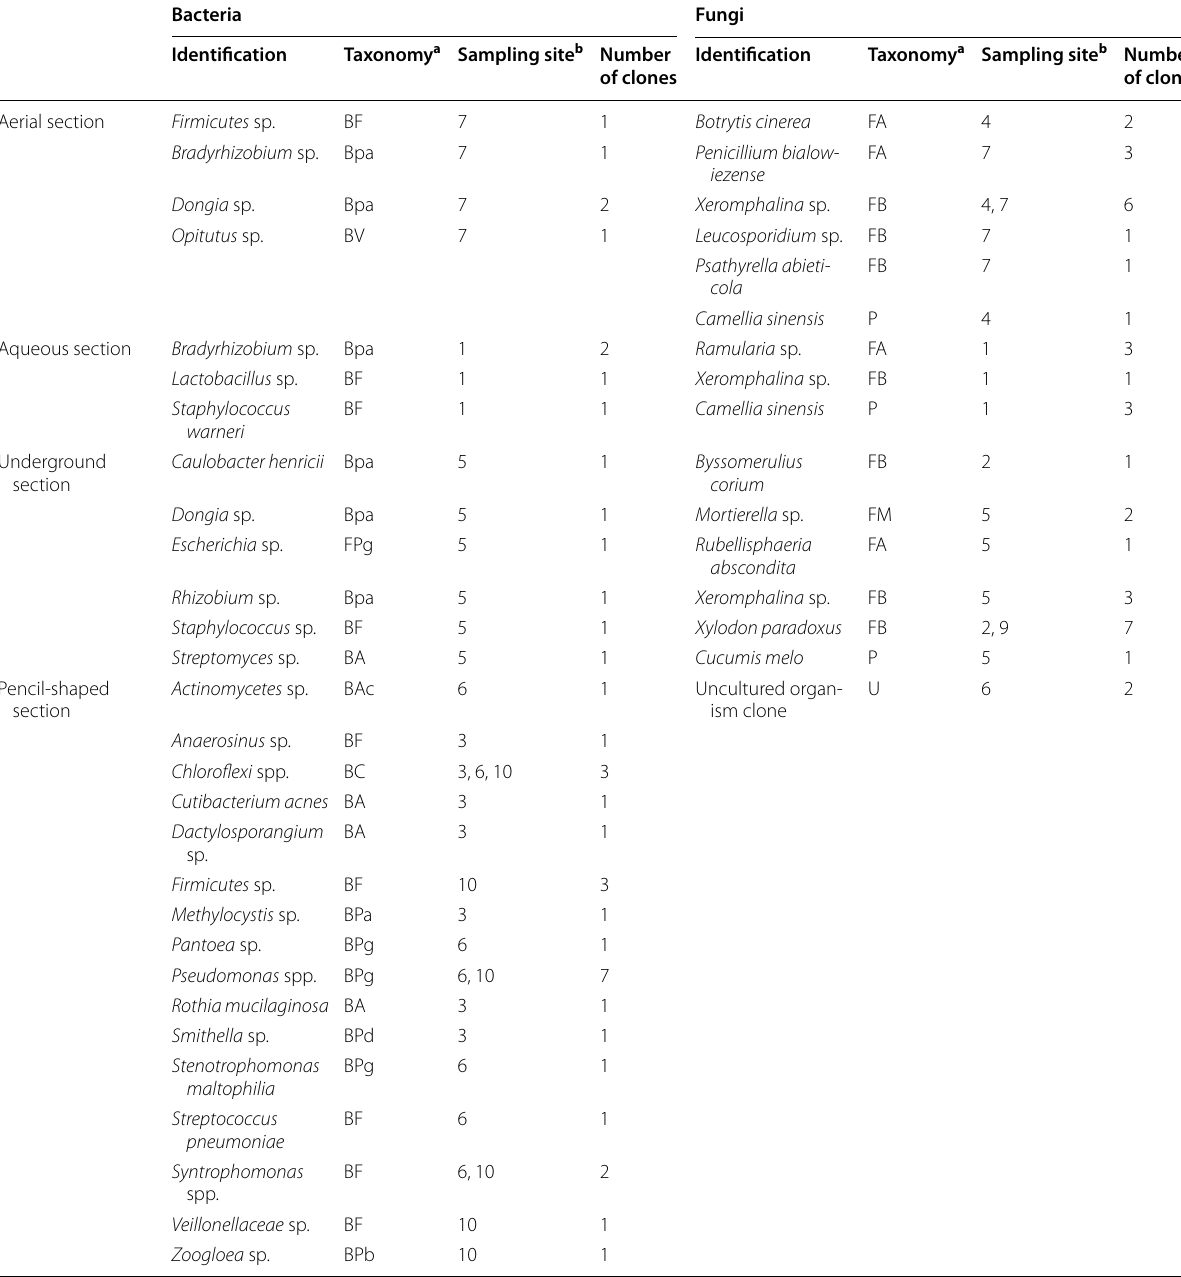
Table 2 Bacterial and fungal species identified in the